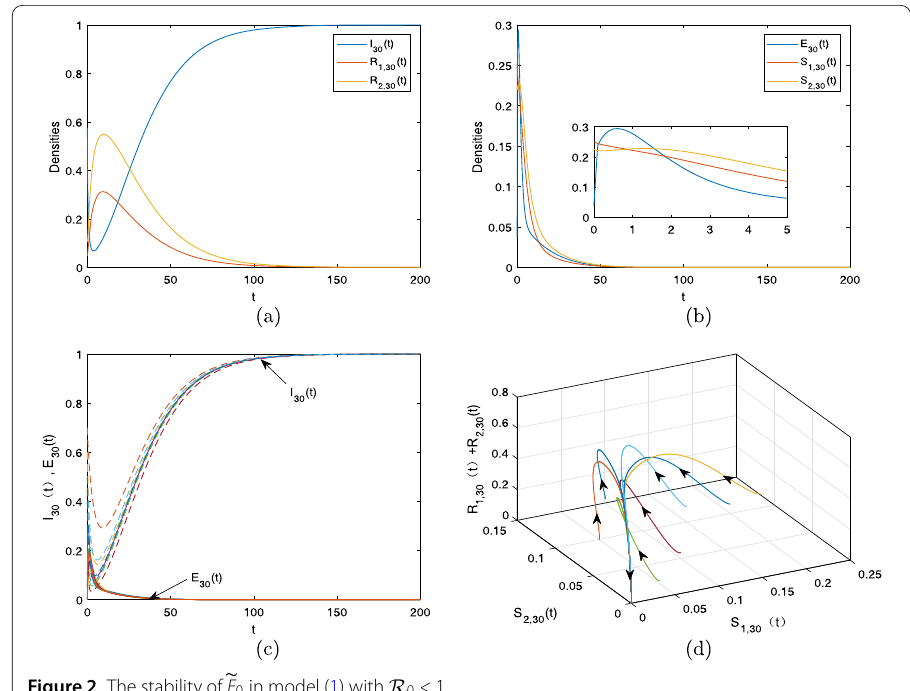
Figure 2 The stability of (cid:18) E 0 in model (1) with R 0 < 1